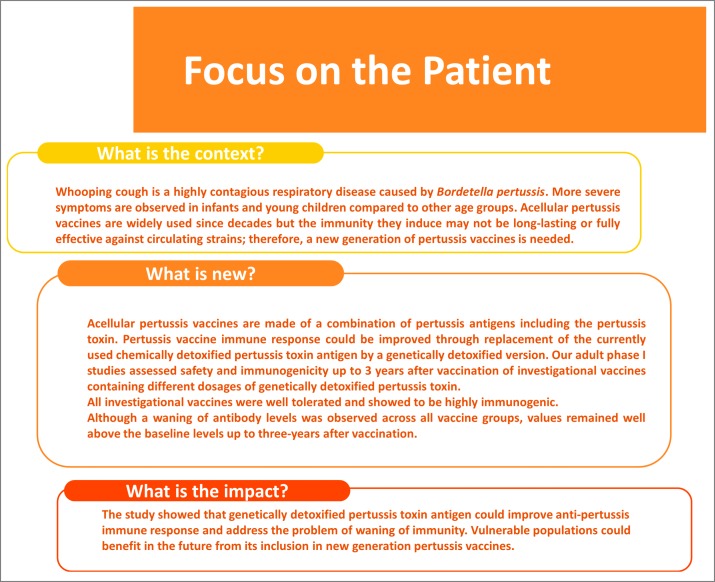
Focus on Patient Section.